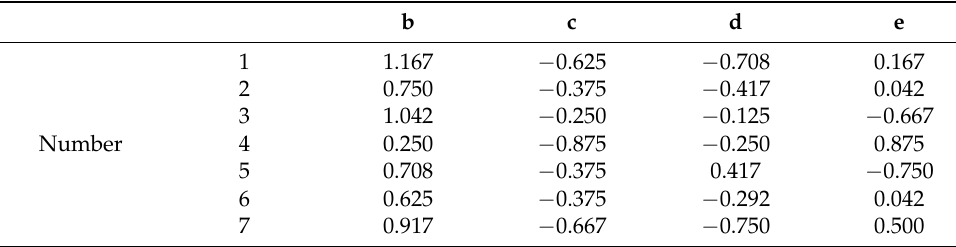
Table 3. Evaluation values by Scheffe’s paired comparison test with respect to Figure 6.